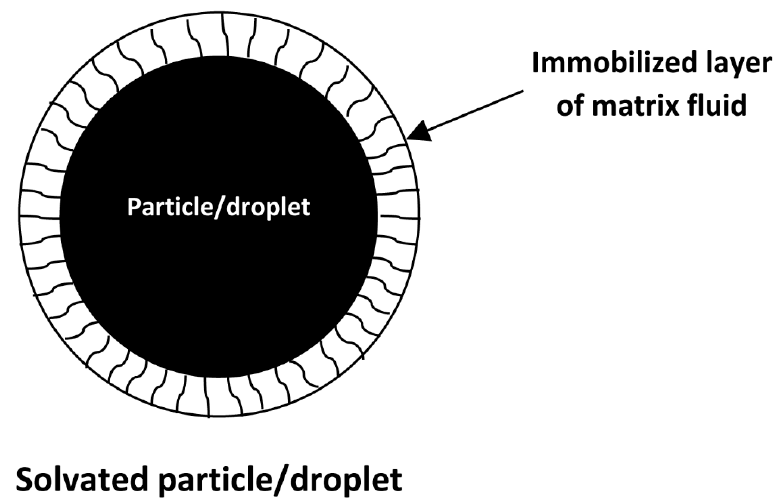
Figure 5. Particle/droplet coated with a thin film of immobilized matrix fluid.